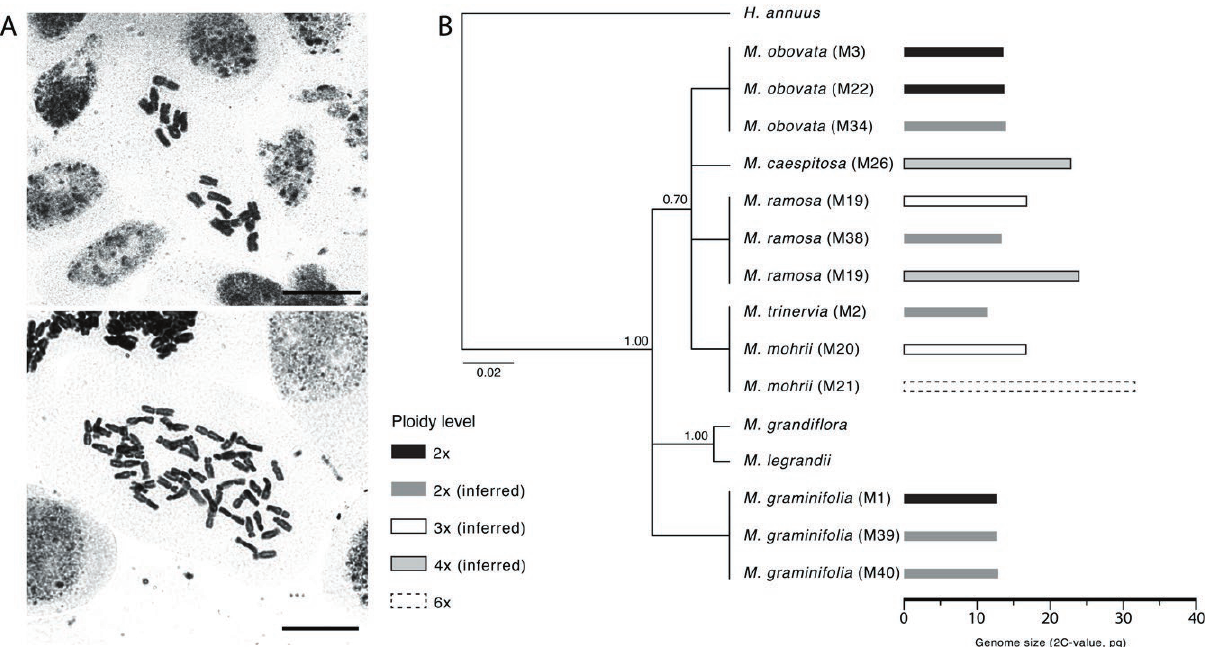
M. ramosa Beadle and F.E.Boynton 1 N = numer of individuals. 2 1 pg = 978 Mbp (Doležel et al. 2003). 3 Cromosome Counts Database (Rice et al. 2015). * Chromosome num- bers inferred from nuclear DNA contents.